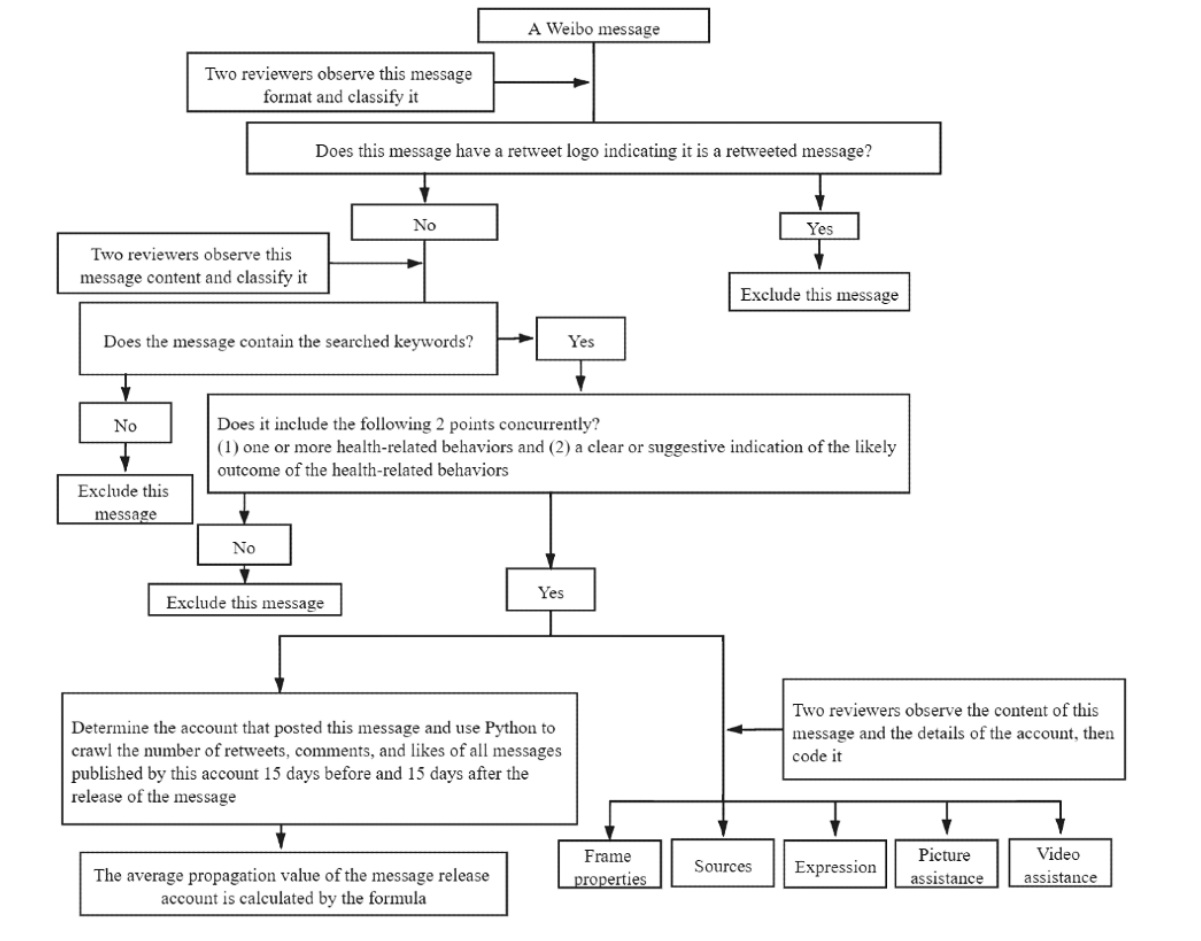
Figure 2. The coding process for the health-promoting